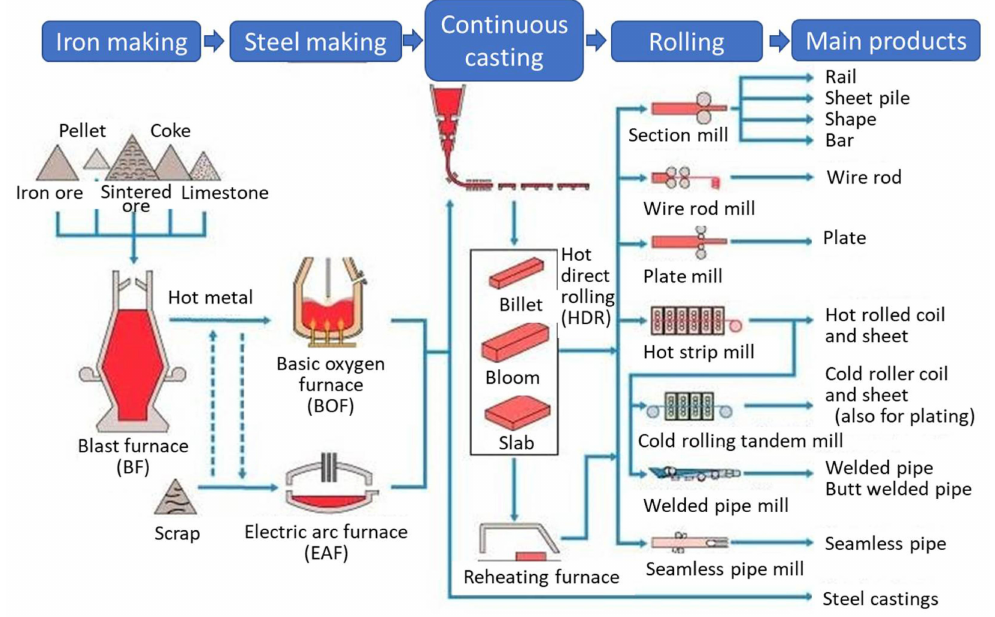
Figure 3. Schematic representation of iron and steel production process consisting of raw material preparation, iron making, steel making, continuous casting and shaping. Thermal spray coatings are employed throughout the manufacturing process. Adapted from [19].